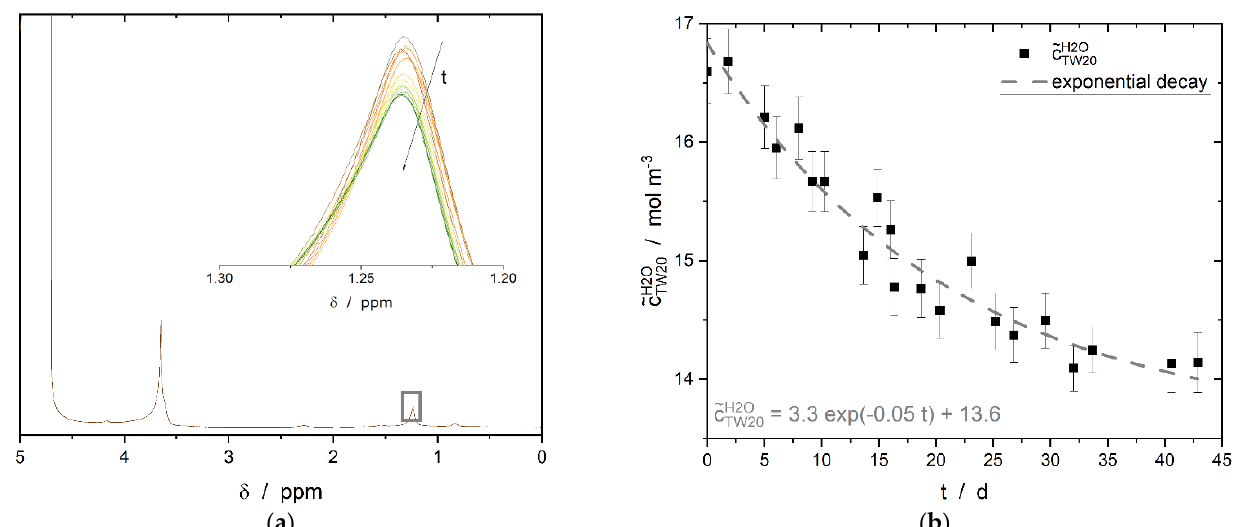
Figure 9. ( a ) 1 H spectra of the aqueous phase, where the surfactant Tween ® 20 was dissolved at the beginning of the experiment. The water peak appears at about 4.8 ppm; all other visible peaks are related to Tween ® 20. Inset: time-resolved evolution of the CH 2 peak of Tween ® 20. ( b ) Time-resolved measurements of Tween ® 20 concentration in the continuous phase over a period of 43 days, determined by NMR spectroscopy. The volume ratio of water and n-hexadecane was 50:50 and the interface had an area of 13.2 mm 2 . Additionally, the fitted exponential decay curve is visible as a dashed line.